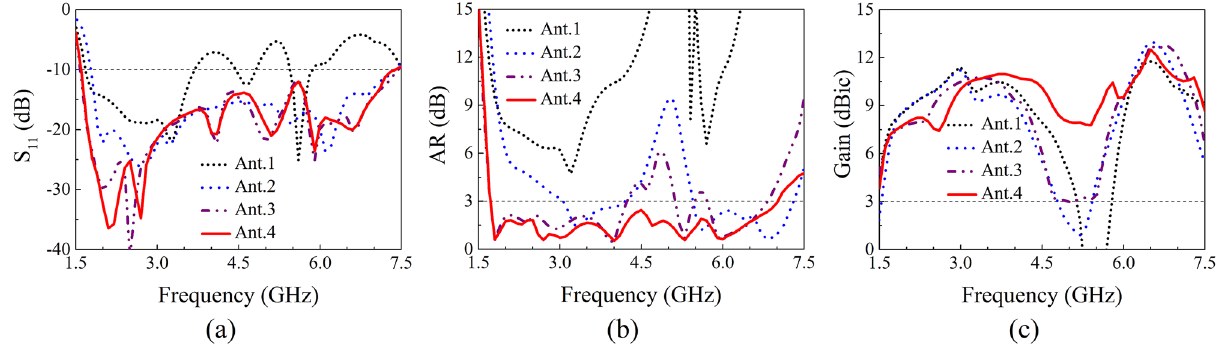
Figure 3. Performance comparisons between different antennas. ( a ) S 11 , ( b ) AR, and ( c )